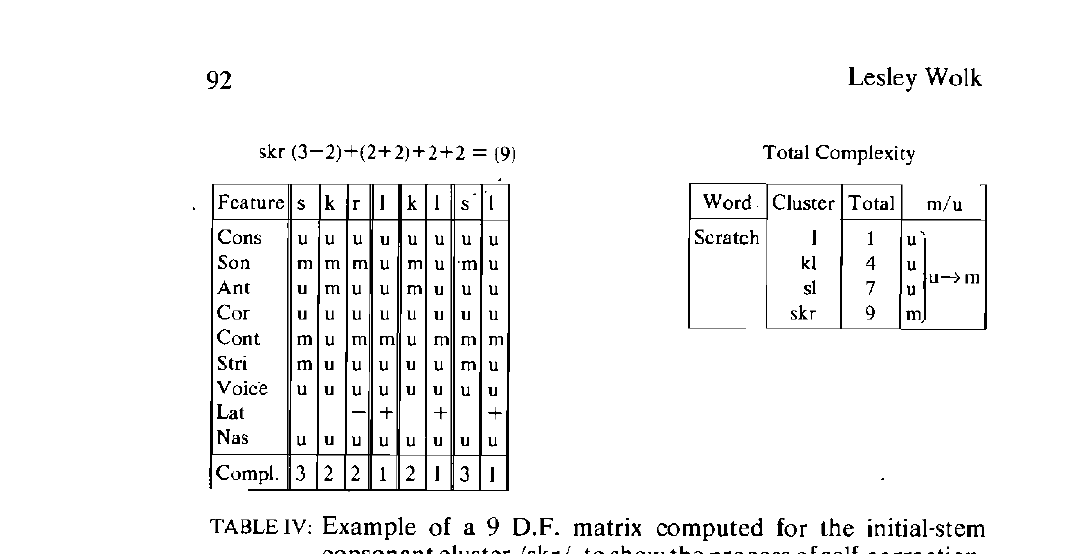
TABLE IV: Example of a 9 D.F. matrix computed for the initial-stem consonant cluster /skr/, to show the process of self-correction.